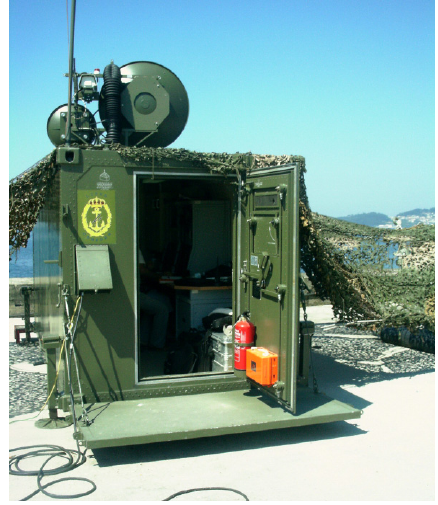
Figure 1. LIBRARCS measurement system.